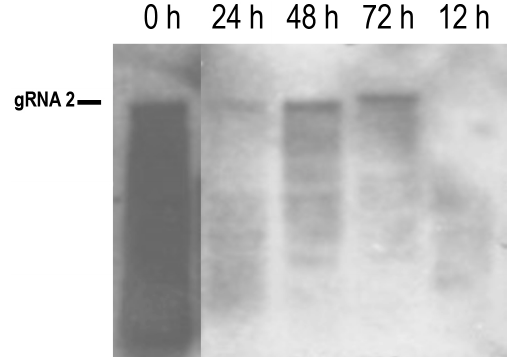
Figure 2. Replication of CYSDV RNA2 occurs in the presence of RNA1, with similar kinetics and a small temporal delay. A time-course northern blot of total RNA extracted from protoplasts co-transfected with equimolar amounts of CYSDV RNA1 and RNA2, hybridised with a dig-labelled riboprobe corresponding to the ( − ) sense CYSDV p26 gene. The position of the RNA2 gRNA is indicated. The apparent shift in the gRNA band at 72 h p.i. is an electrophoresis artefact.